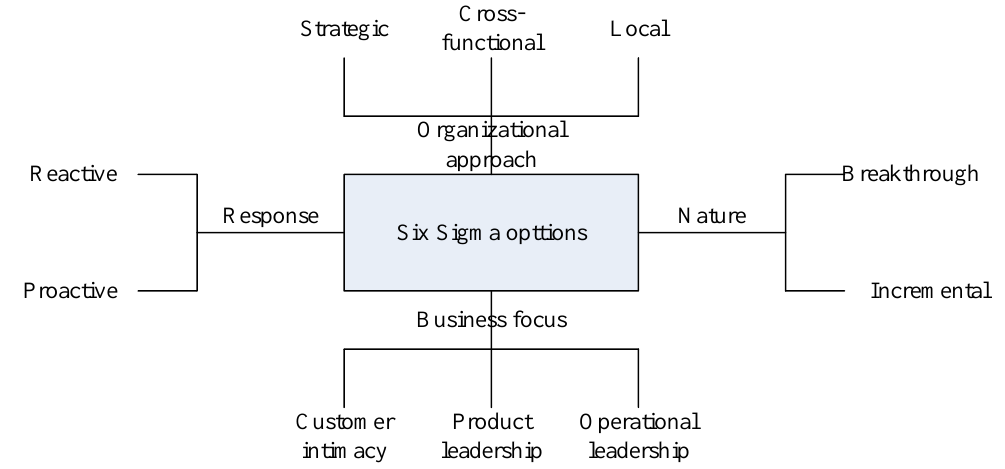
Fig. 2. Lean Six Sigma implementation focus (Truscott,